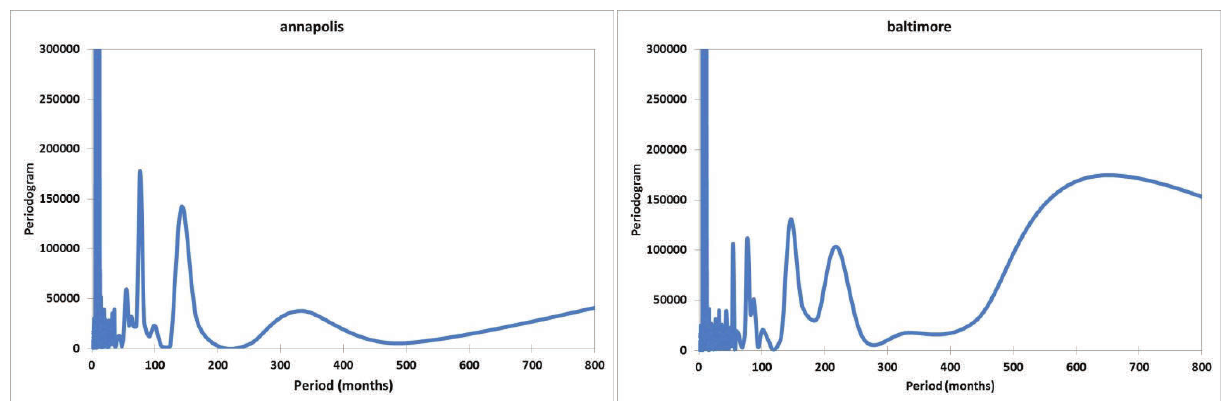
Figure 6. Periodogram from the spectral analysis of the monthly departures from the linear trend in the 6 stations in Maryland, Virginia and District of Columbia with more than 65 years of recording at the present time (data from [12]; pictures from